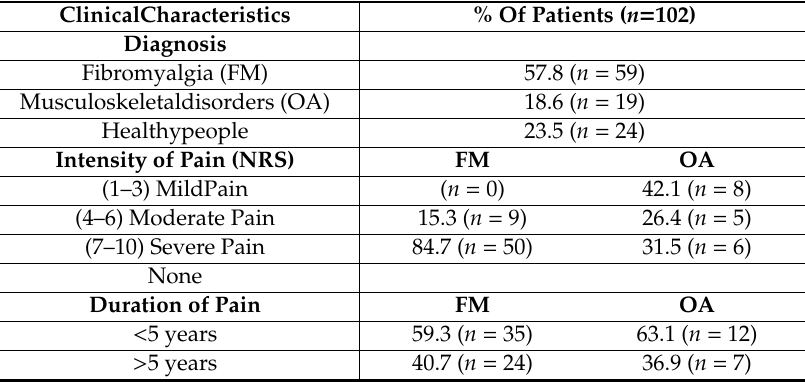
Table 1. Clinical characteristics: patients and healthy subjects were analyzed considering the diagnosis, the intensity of pain (11-point numerical rating scale (NRS)) and the duration of pain (years).